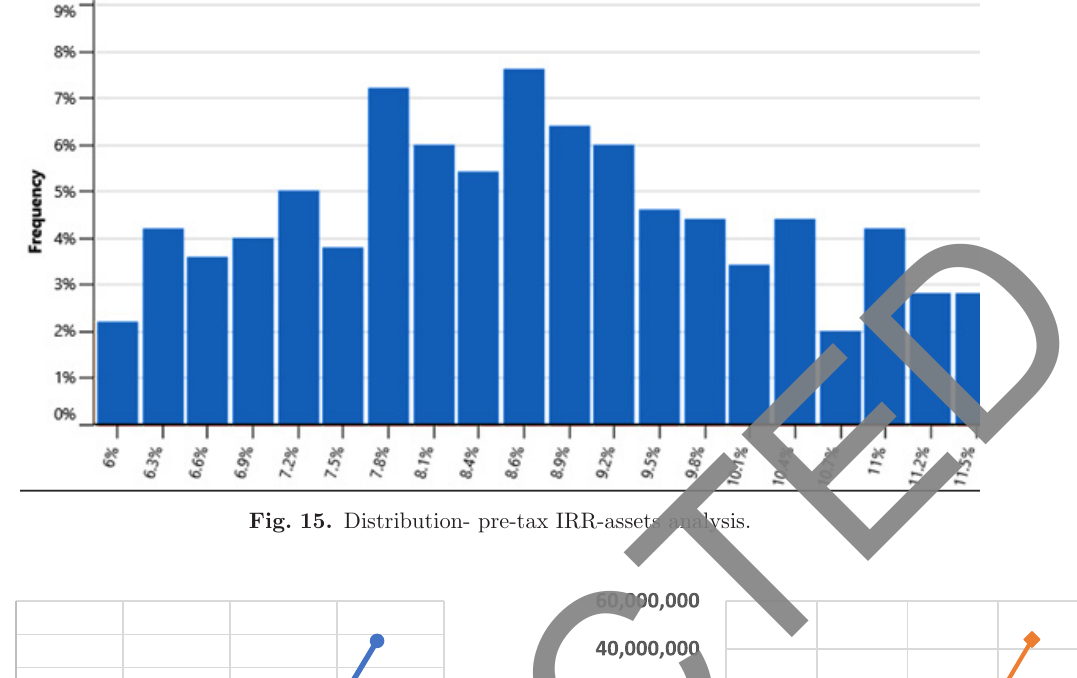
Fig. 15. Distribution- pre-tax IRR-assets analysis.